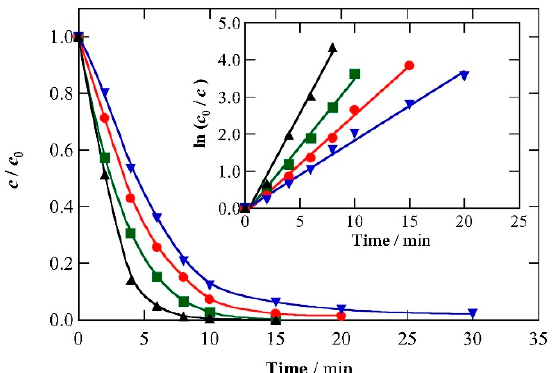
Figure 11. Influence of the aqueous matrix on the normalized captopril concentration decay during the SPEF treatment of 2.5 L of 0.230 mM drug solutions with 0.50 mM Fe 2+ at pH 3.0 and 35 °C using a solar pre-pilot flow plant with a Pt/air-diffusion cell at j = 50 mA cm − 2 and liquid flow rate of 180 L h − 1 . Matrix: ( ▲ ) Urban wastewater, ( ■ ) urine 1 (13.9 mM urea + 0.073 mM uric acid + 0.367 mM creatinine), ( ● ) urine 2 (27.8 mM urea + 0.146 mM uric acid + 0.734 mM creatinine) and ( ▼ ) urine 3 (55.6 mM urea + 0.292 mM uric acid + 1.47 mM creatinine). The inset panel shows the kinetic analysis of the above concentration decays assuming a pseudo-first-order reaction. Reprinted with permission from ref. [80]. Copyright 2020 Elsevier.